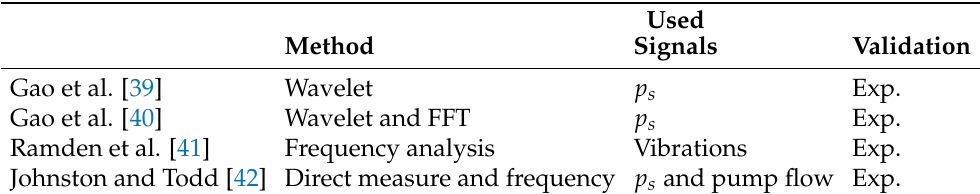
Table 6. Covered fault detection methods for pump faults. The notations of the used signals can be found in Figure